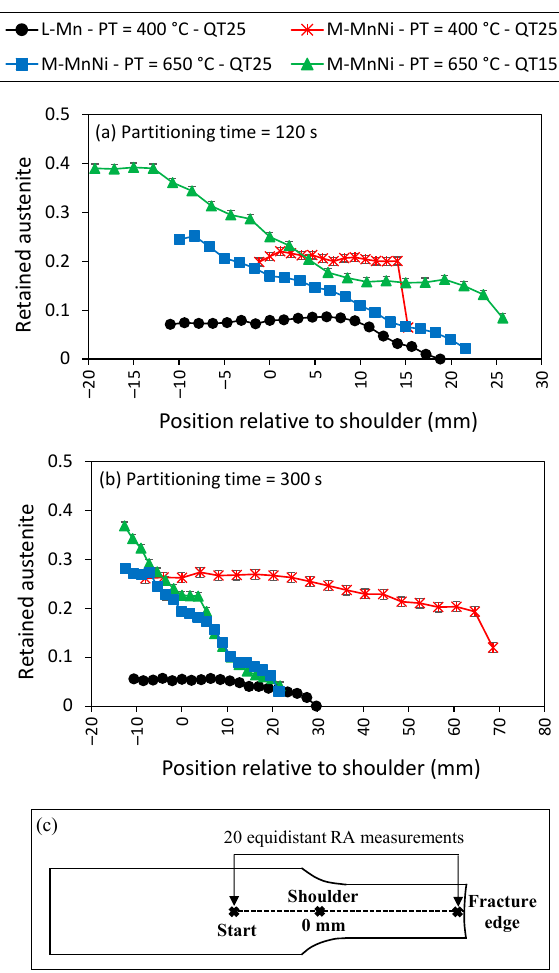
Figure 10. Retained austenite results of the X-Ray Diffraction scans performed along tensile specimen length after Q&P treatments of L-Mn and M-MnNi steels with different PTs (400 °C and 650 °C), QTs (QT25 and QT15) and Pts: ( a ) 120 s and ( b ) 300 s. All line scans were aligned at the shoulder position of the tensile test specimen (denoted as 0 mm). ( c ) Schematic of the tensile specimen showing the line where RA scans were performed.